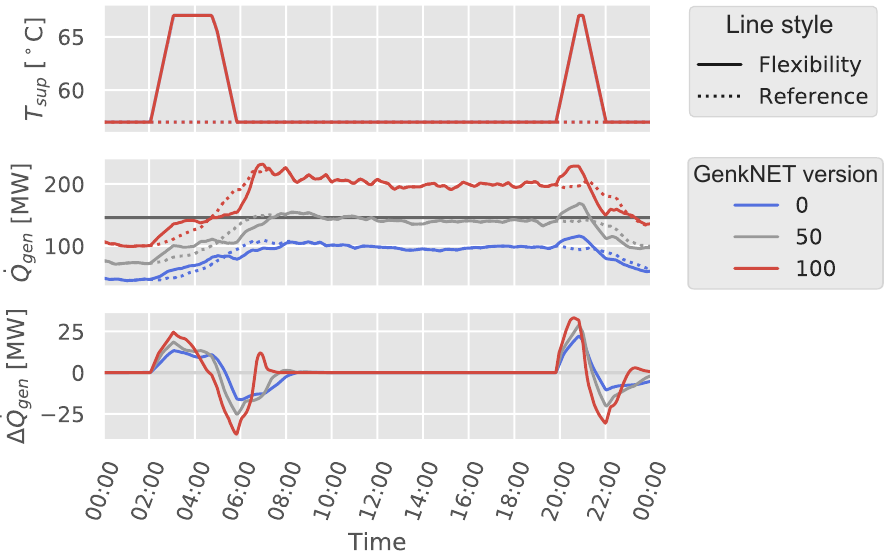
Figure 11. The application of control strategy 100 on a GenkNET version with low (0), medium (50) and high (100) heat demand on the Winter_Large ∆ p e day with a base load ratio of 95%. The maximum base unit heat generation is indicated by the horizontal grey